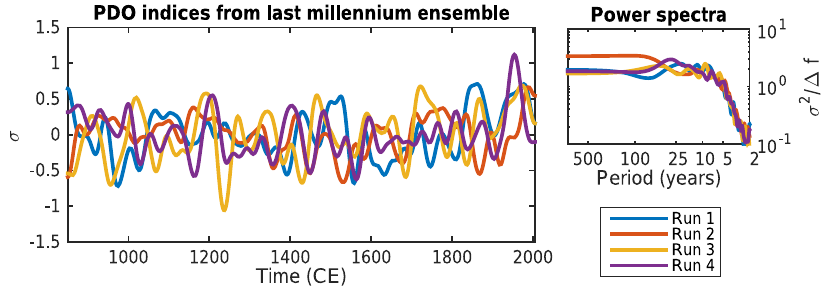
Figure 7. Time series (low-pass filtered to emphasize decadal variations) of the PDO from the four runs of the CESM Large Ensemble (LENS; Kay et al., 2015) experiment (left) and the power spectra of each run (right).